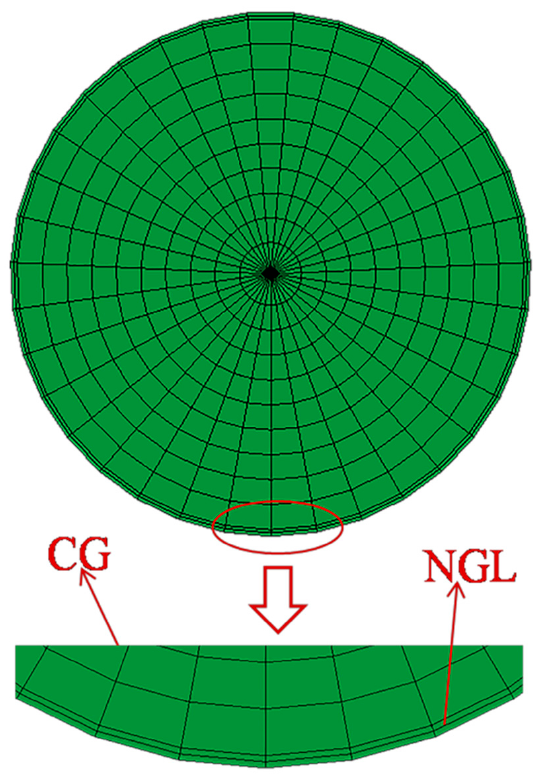
Figure 5. CFE model for the SMATed specimen with a nanograined layer (NGL) thickness of 20